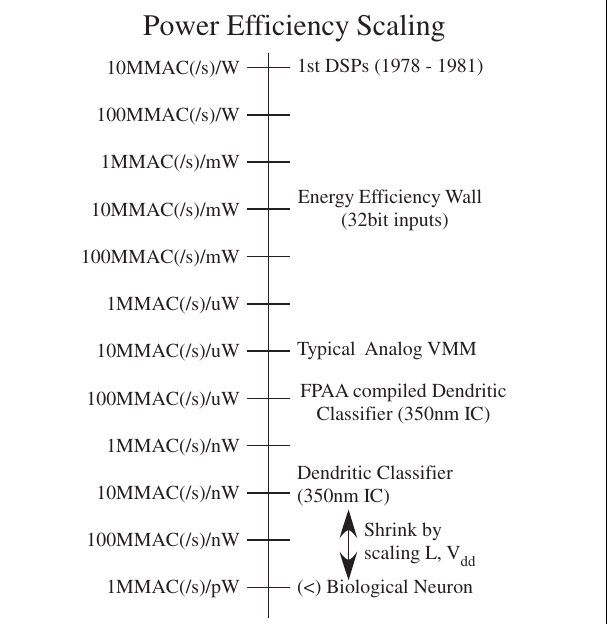
FIGURE 26 | A summary comparison of power efficient computational techniques, including digital, analog Signal Processing (SP) techniques, and the potential for neuromorphic physical algorithms. The potential of 8–9 orders of magnitude of achievable computational efficiency encourages a wide range of neuromorphic research going forward.